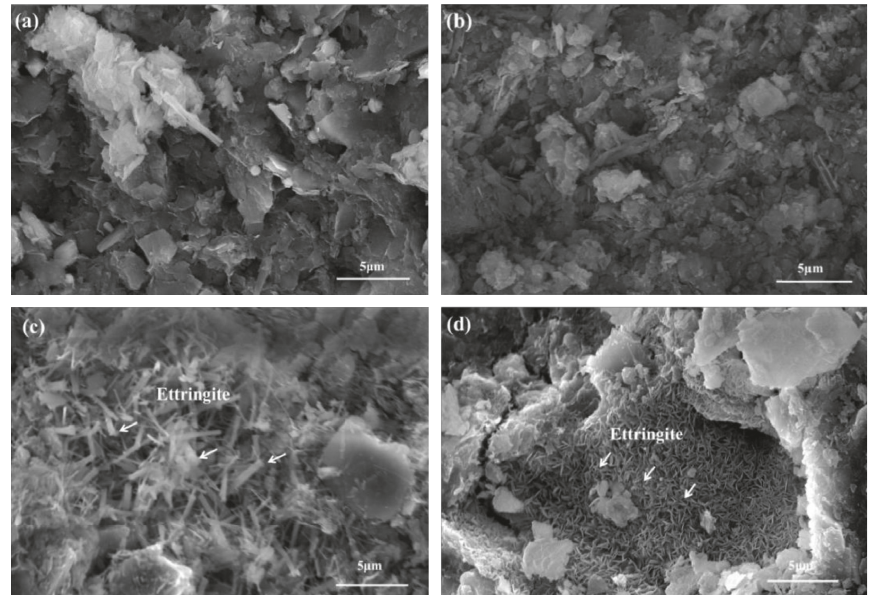
Figure 9: SEM images of dried dredged sludge and solidified sludge after curing for 28 days: (a) dried dredged sludge; (b) with 0% strong oxidant; (c) with 2% GH; (d) with 2% KMnO 4